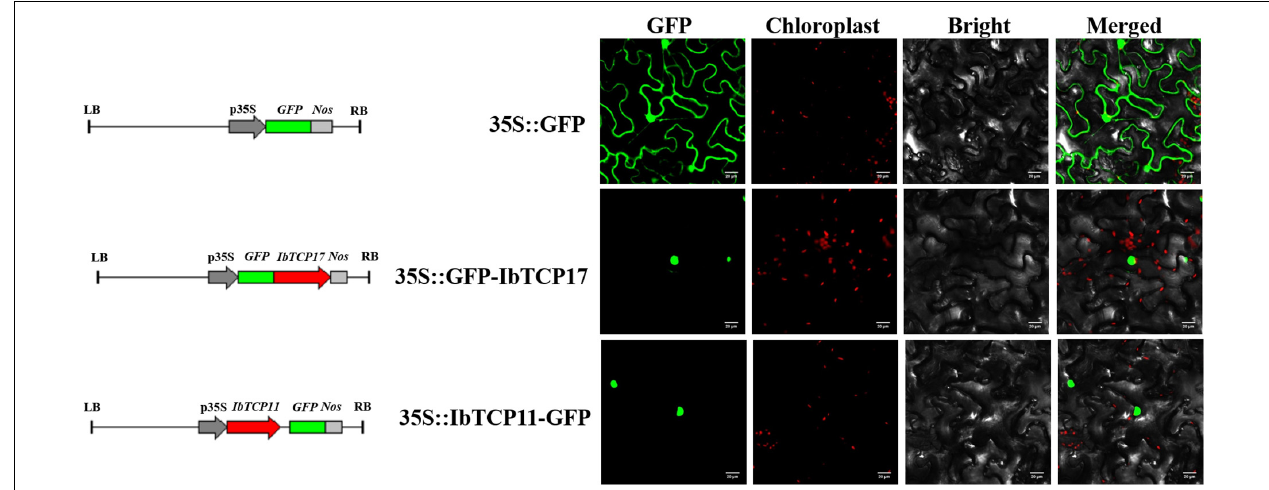
FIGURE 6 | Subcellular localization of two GFP-fused sweet potato TCP proteins. The two IbTCP-GFP fusion proteins (IbTCP11-GFP and IbTCP17-GFP) were transiently expressed in tobacco leaves and observed by confocal microscopy 72 h later. GFP driven by the 35S promoter was used as a control. The left, middle-left, middle-right, and right panels stand for photoes taken in dark, chloroplast, bright, and merged views, respectively. Bars are 20 µ m.